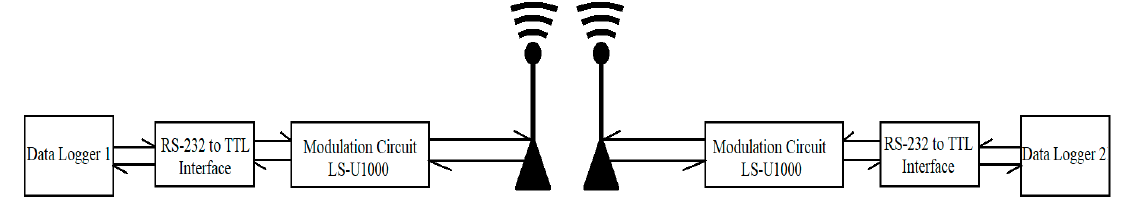
Figure 11. Overall radio communication system.